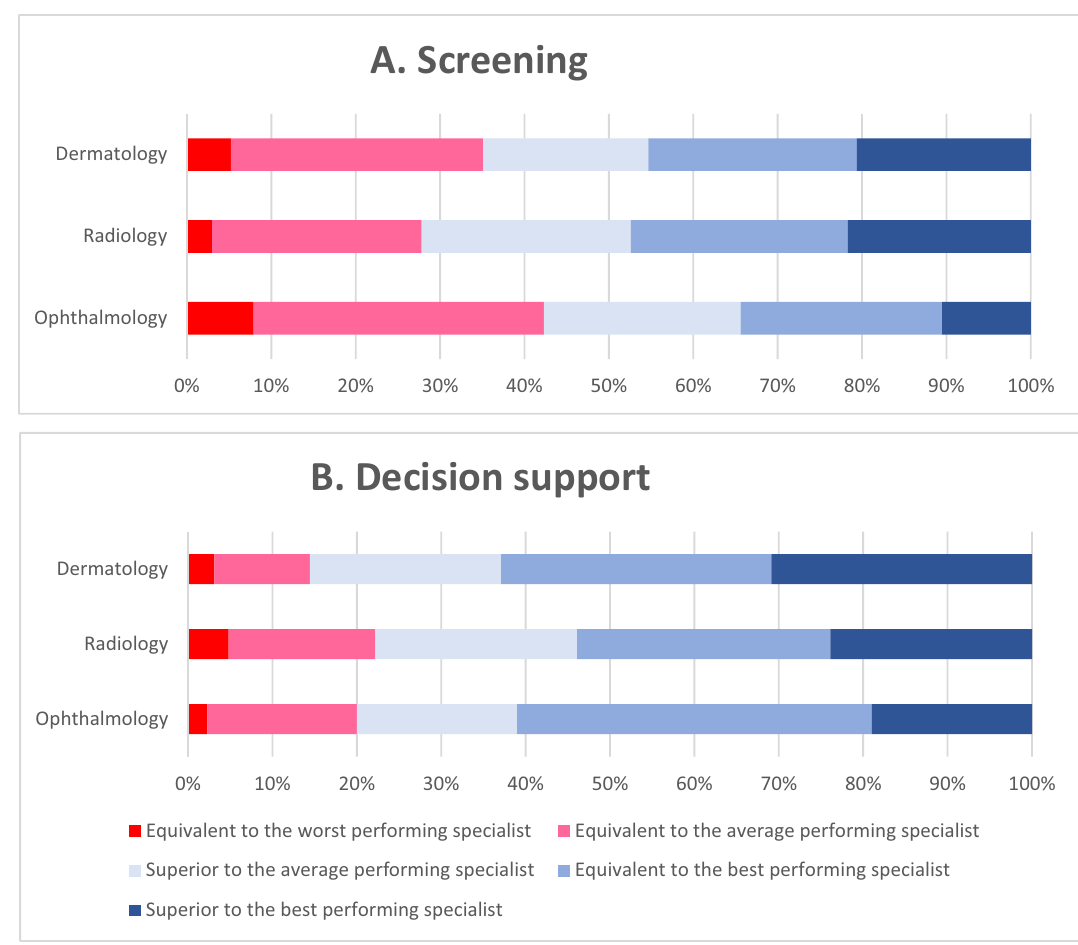
Figure 6. 100% stacked bars showing the acceptable level of error for an AI tool used for ( A ) disease screening and ( B ) clinical decision